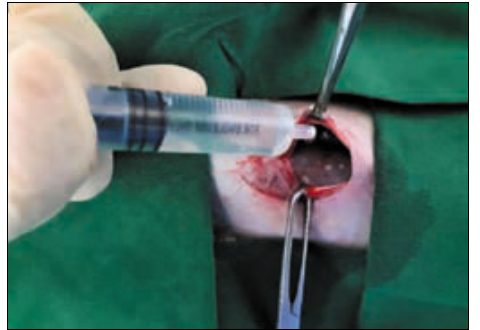
Fig. 1. Pectin-honey hydrogel